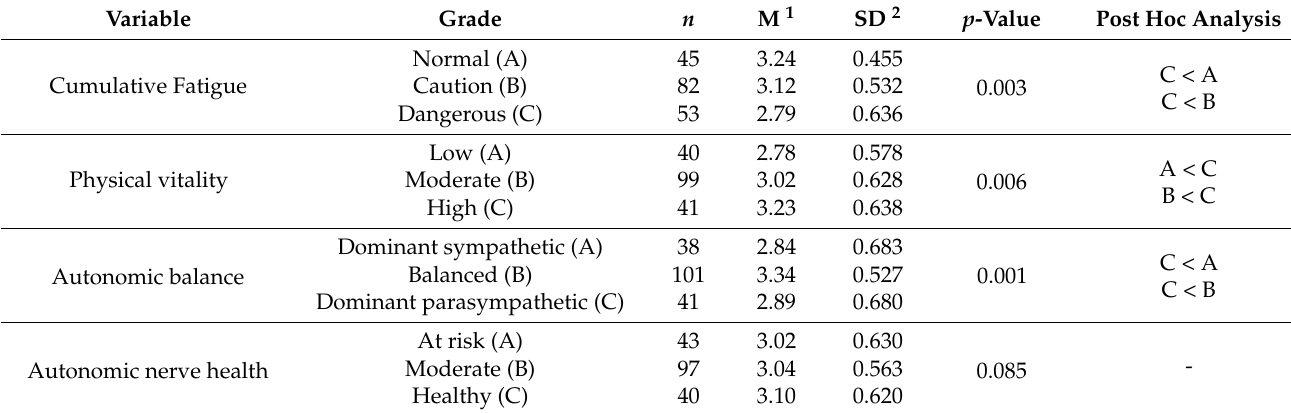
Table 8. Statistical analysis results for differences in safety commitment according to pulse wave